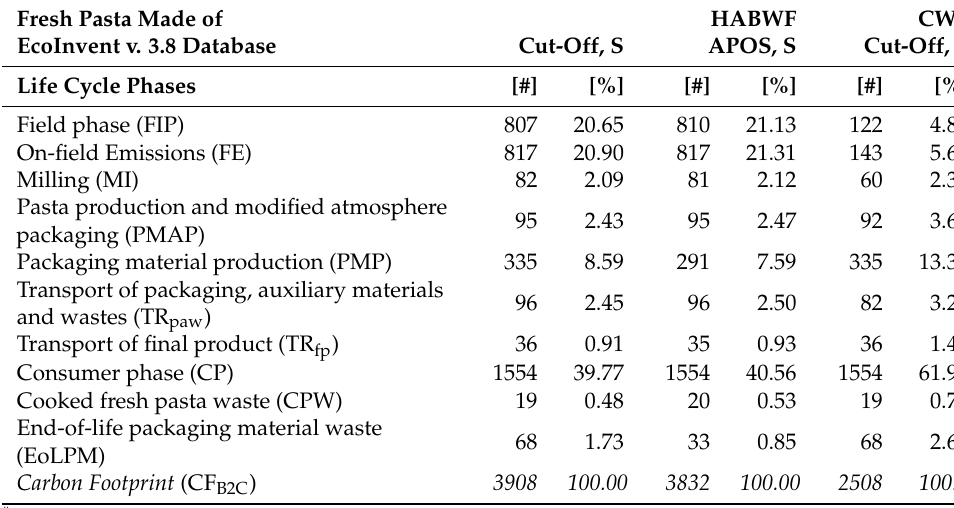
Table 6. Percentage contribution of the different life cycle phases to the business-to-consumer carbon footprint (CF B2C ) of a functional unit (1 kg) of fresh pasta made of high-amylose bread wheat flour (HABWF) or common wheat flour (CWF) and packed in 0.5-kg PE bags when using the characterization factors extracted from the Cut-off or APOS system model of the Ecoinvent v. 3.8 database. Fresh Pasta Made of HABWF CWF EcoInvent v. 3.8 Database Cut-Off, S APOS, S Life Cycle